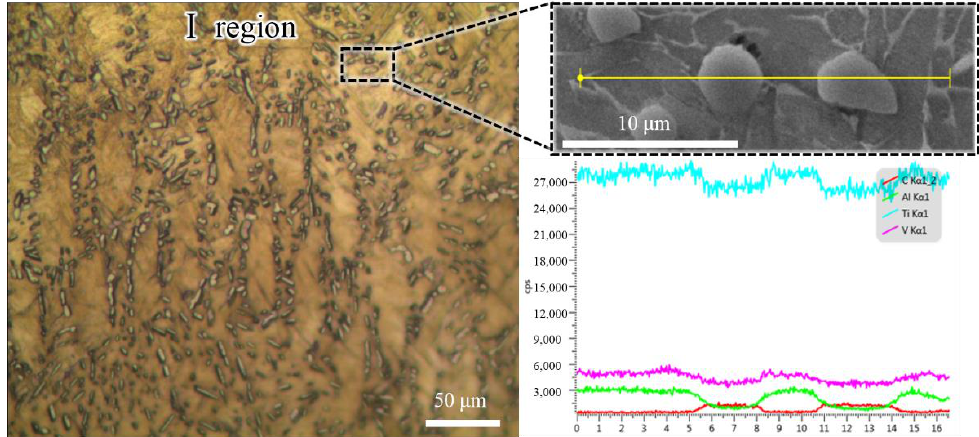
Figure 7. Metallographic and element distribution images of the Ι region.